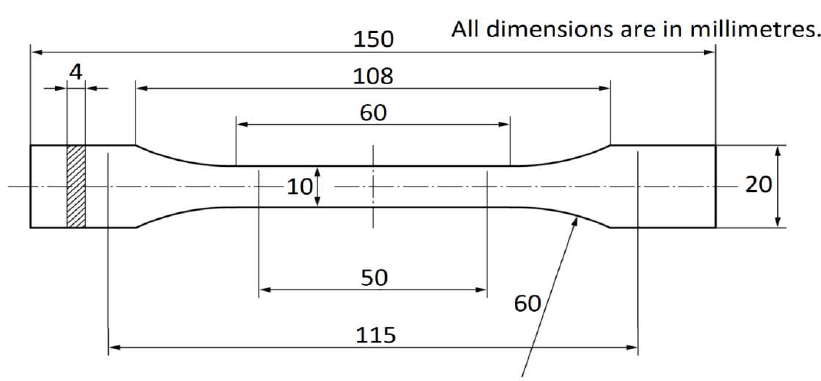
Figure 3. Dimensions of the dog-bone sample.